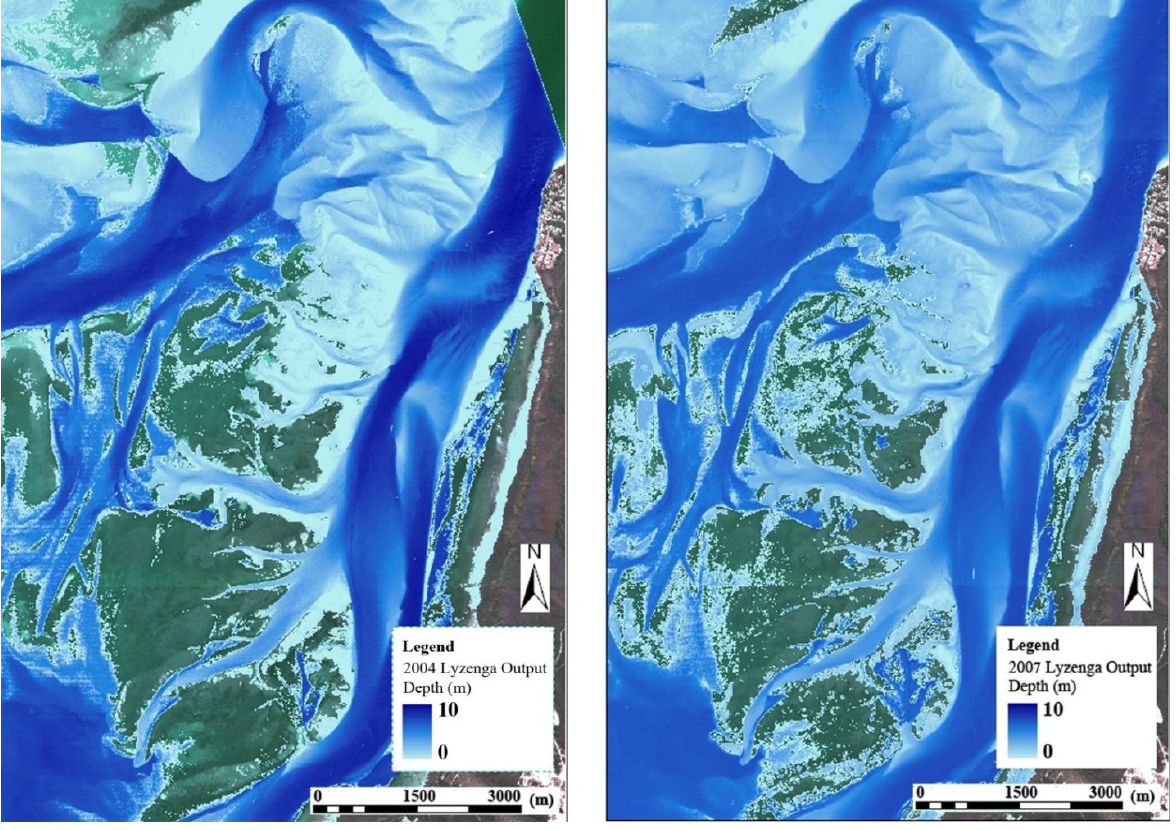
Figure 2. Bathymetry maps produced from the 2004 (left) and 2007 (right) imagery using the Lyzenga algorithm, excluding exposed areas and seagrass (marked as green).